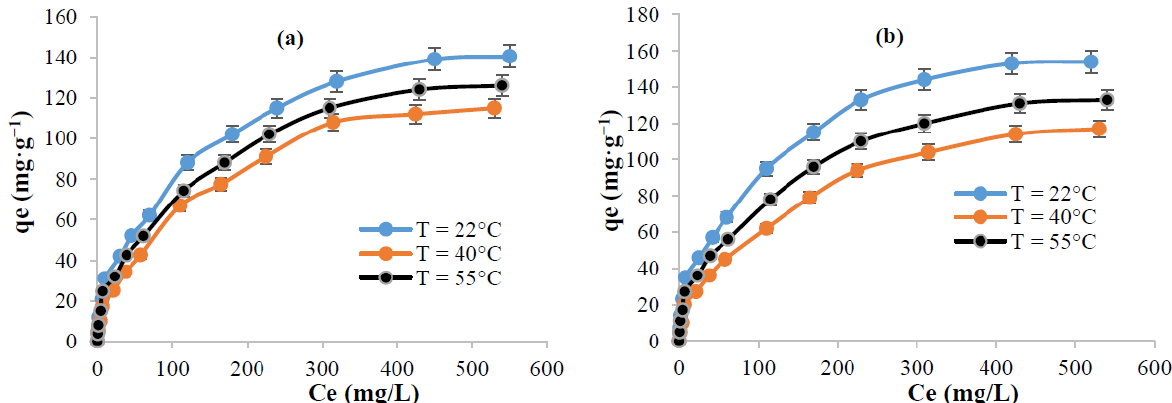
Figure 7. Effect of temperature on the adsorption of: ( a ) methylene blue and ( b ) crystal violet (pH = 6, time = 40 min, Volume = 10 mL, and adsorbent dosage = 0.012 g) (For each measurement, 3 replicates are done).